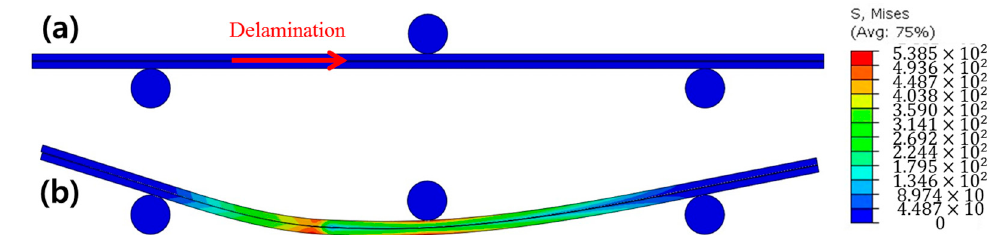
Figure 3. ENF model of ( a ) initial stage, ( b ) just before crack propagation (W3, at 10 s).